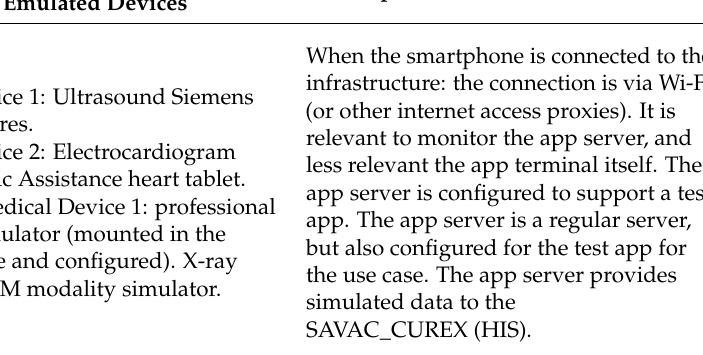
Table 3. Description of the information sharing capacity, POC medical devices and smartphone within the use case developments. Information Sharing